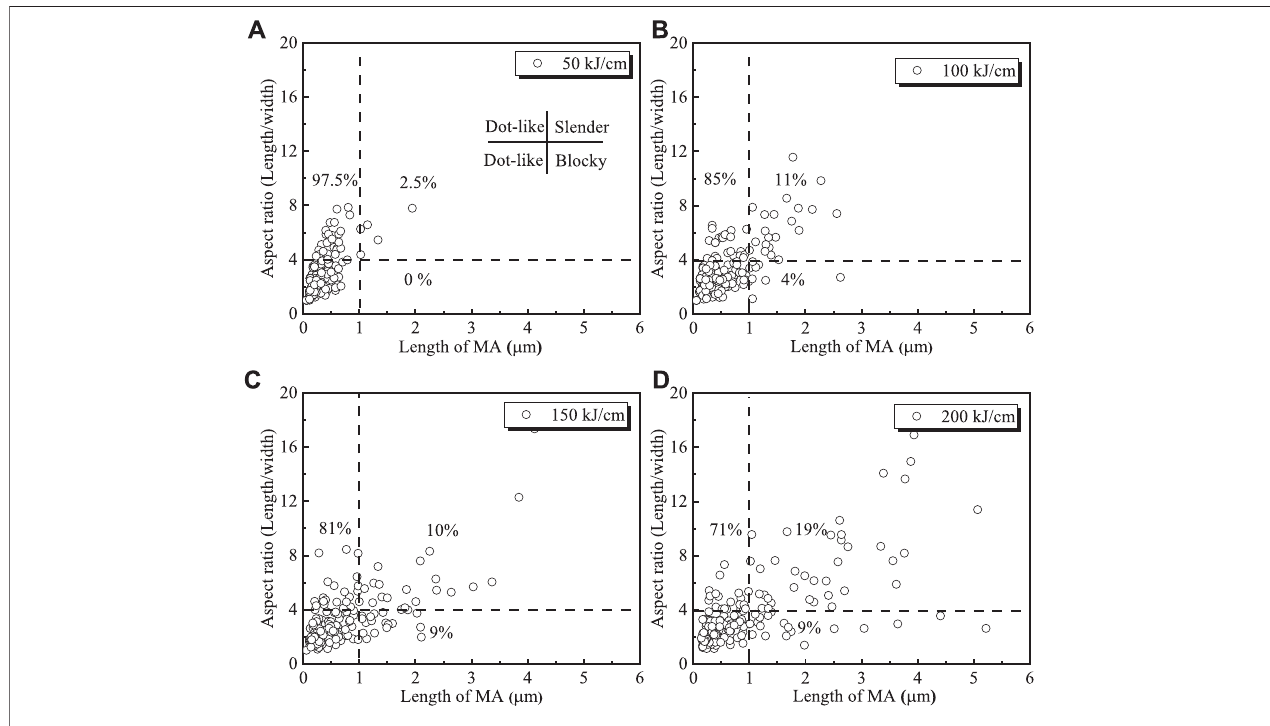
FIGURE 10 | Effect of heat input on the length and aspect ratio of M – A constituents in the CGHAZ with the heat inputs of (A) 50, (B) 100, (C) 150, and (D) 200 kJ/cm.